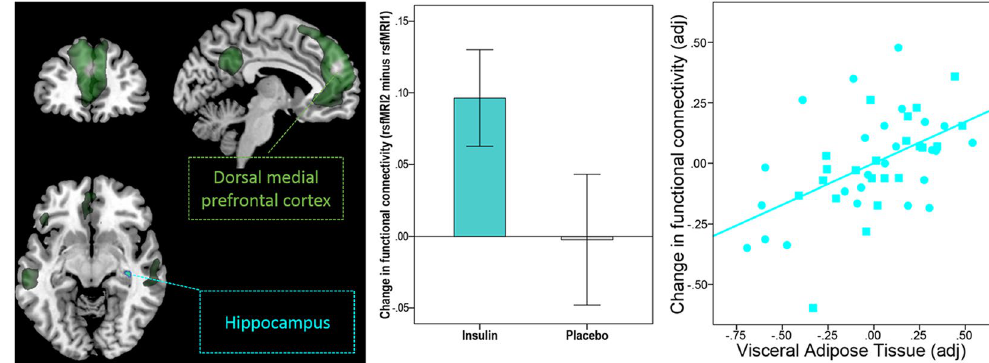
Figure 3. Intranasal insulin increases functional connectivity between the dorsal medial prefrontal cortex (PFC) of the default-mode network (DMN) and the hippocampus in lean, overweight and obese participants. Group-averaged DMN of lean and overweight/obese participants under baseline condition (rs fMRI1 ) for the dorsal medial PFC seed region is displayed in dark green (p FWE < 0.05, whole-brain corrected). Cyan- color coded region reveals voxels within the right hippocampus showing a significant change in functional connectivity within the DMN based on the dorsal medial PFC seed region after intranasal insulin compared to placebo (p FWE < 0.05 small volume corrected). Bar plot in the middle shows change in functional connectivity after intranasal insulin and placebo (rs fMRI2 minus rs fMRI1 ) between the dorsal medial PFC and the hippocampus in lean, overweight and obese participants (i.e. the extracted differential correlation coefficients of the right hippocampus). Partial correlation plot on the right shows significant correlation between visceral adipose tissue and the intranasal insulin induced change in functional connectivity between dorsal medial PFC and hippocampus adjusted for total intracranial volume, sex, age and BMI (p < 0.001, r adj = 0.529). Circles represent lean participants and squares represent overweight and obese participants.